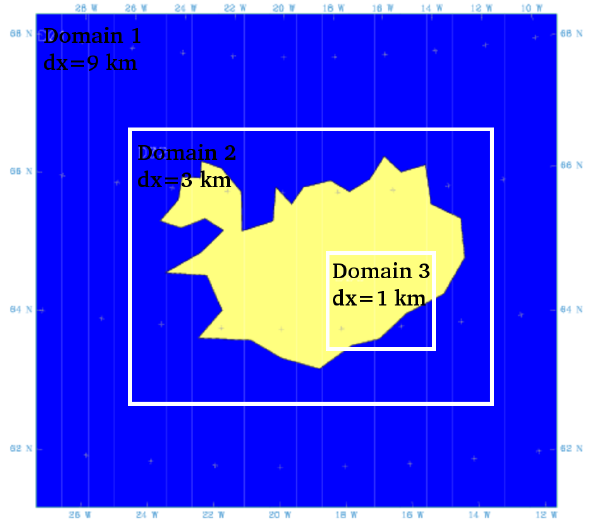
Figure 3: MM5 domain setup of the ÓÁ-07 experiment, the number of horizontal gridpoints for domains 1, 2 and 3 are 95 × 90, 196 × 148 and 175 × 157, respectively. Domain 3 is the same domain as is used in this experiment. All simulations employ 40 vertical levels.